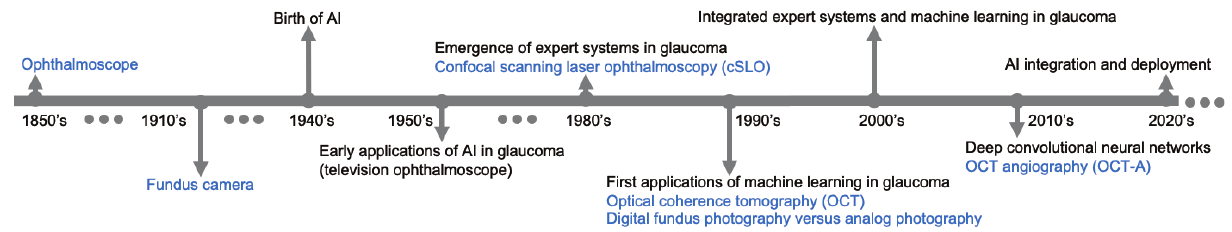
Figure 1. Timeline of major retinal imaging instruments and landmark artificial intelligence applications in glaucoma. Introduction of landmark imaging instruments are listed in blue and AI events are provided in black. AI, artificial intelligence; OCT, optical coherence tomography; OCTA, OCT